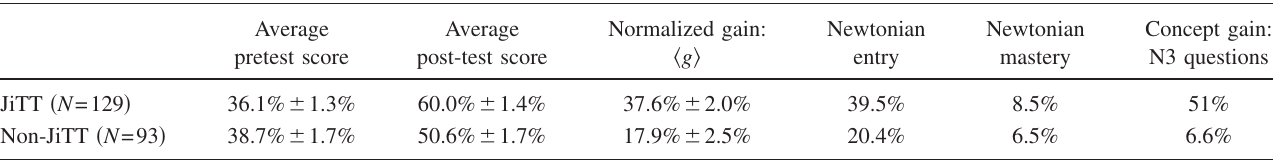
TABLE II. Databased on FCI pretest and post-test scores for two groups, JITT and